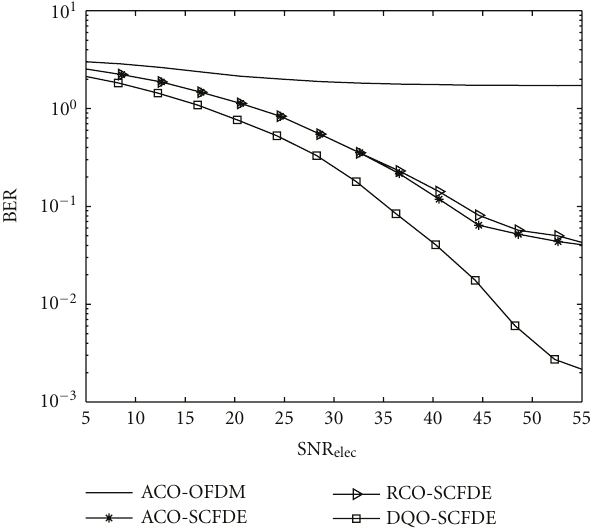
Figure 17: MMSE BER comparison of ACO-OFDM, ACO-SCFDE, RCO-SCFDE, and DQO-SCFDE with N = 64, 64 QAM input symbols with average power 0.1W, L = 3.